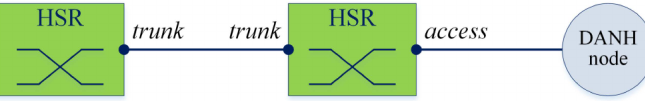
Figure 4. Port types of HSR SwitchBoxes.